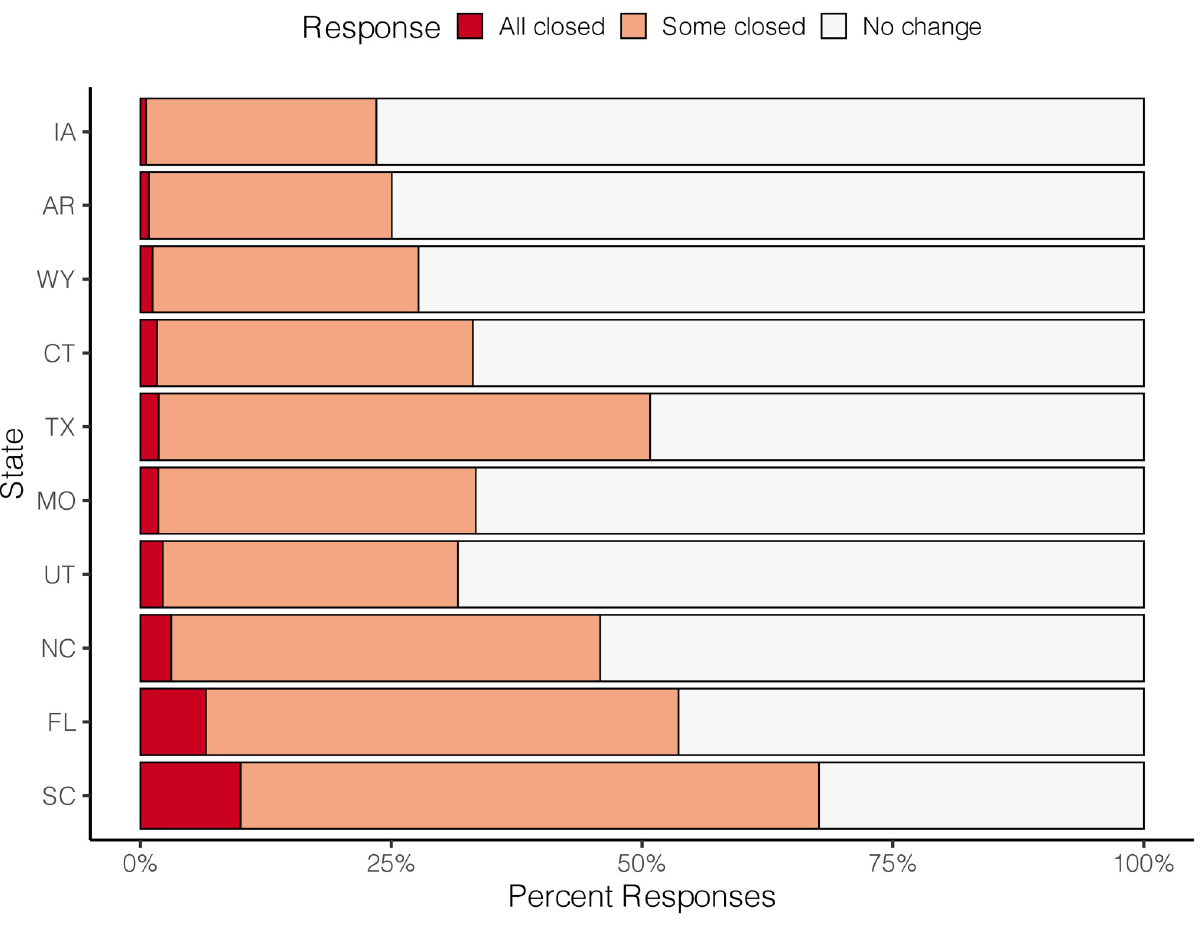
Fig 6. Angler-reported changes to fishing access grouped by